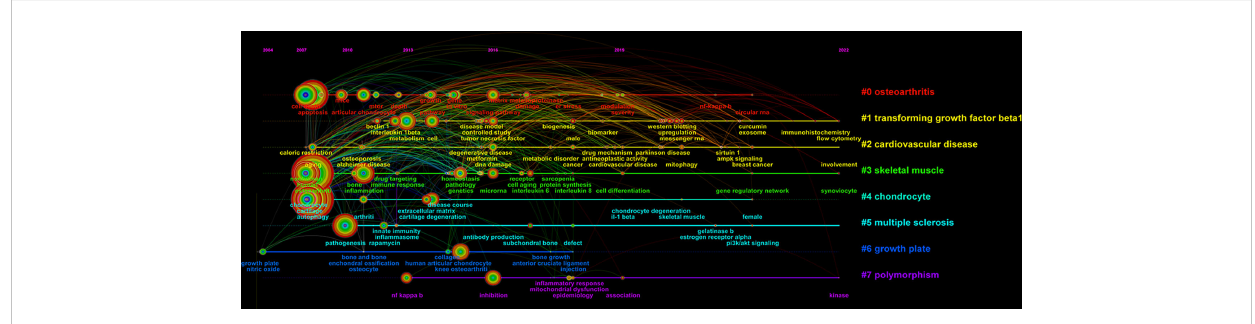
FIGURE 6 CiteSpace visualization map of timeline viewer related to autophagy in OA.